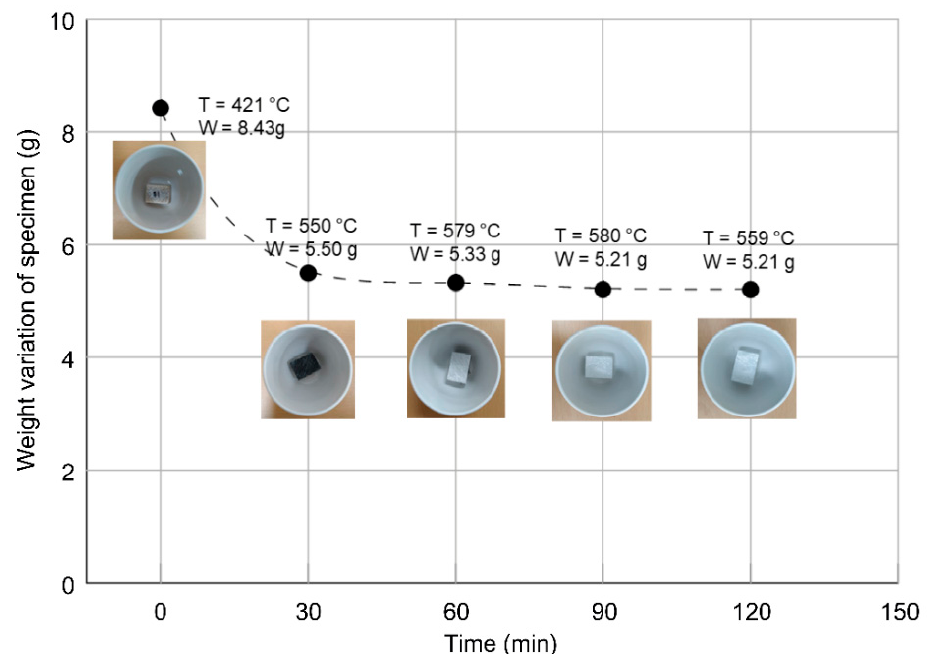
Figure 12. Changes in weight of specimens due to combustion (Gc 64 wt.%, Specimen #1). Table 9. Gc calculation result obtained from the burn-off method (design Gc 40 wt.%).